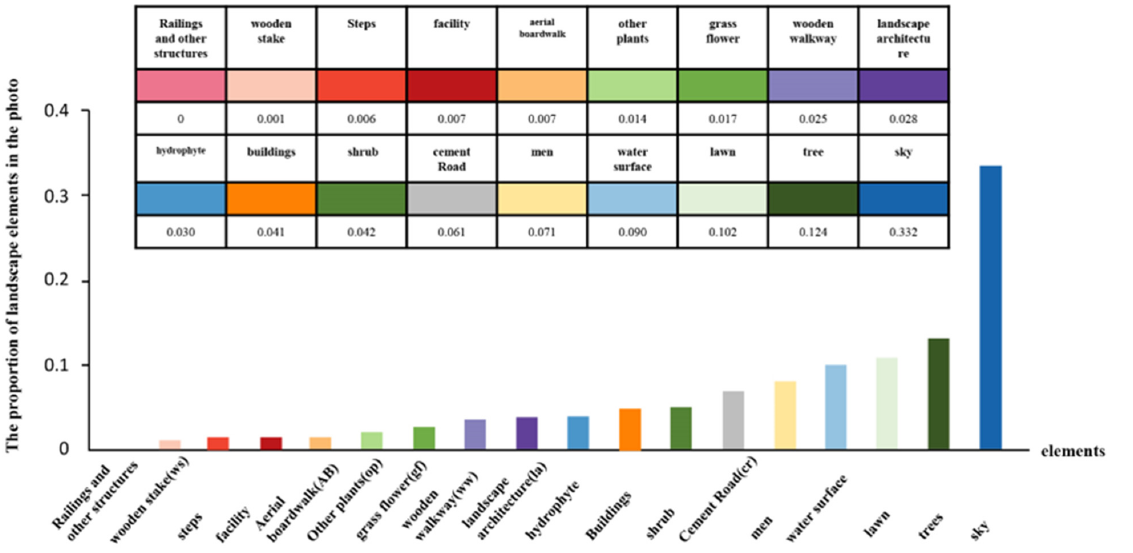
Figure 3. Photo element recognition statistics.